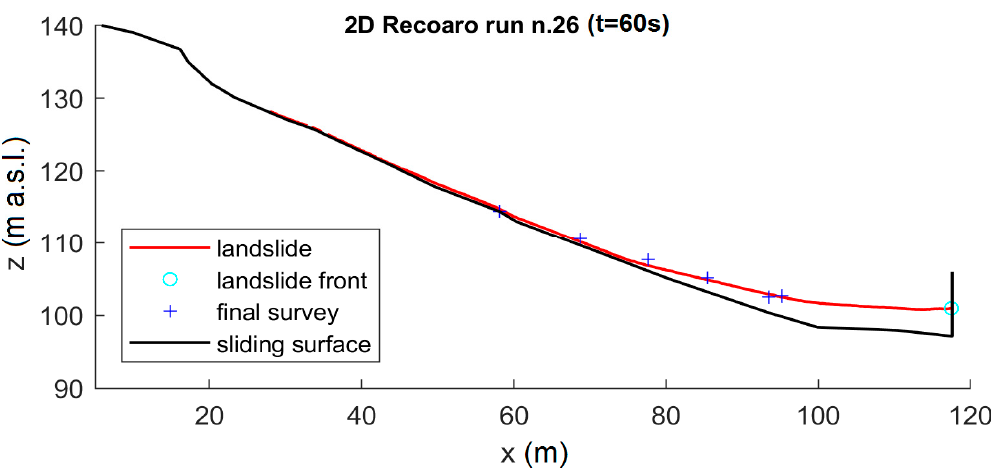
Figure 5. Simulated final profile of the landslide at t = 60 s (red line). The upper part of the landslide profile is compared with experimental points from the post-event survey (blue markers).